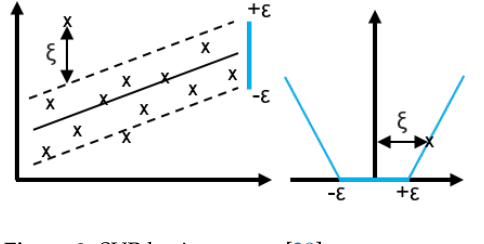
Figure 2. SVR basic concept